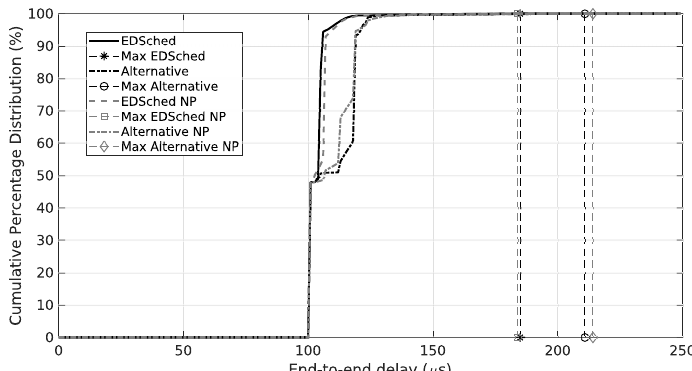
Figure 6. CaseB-Event-drivendelaycumulativepercentagedistributionwithandwithout(NP) preemption.